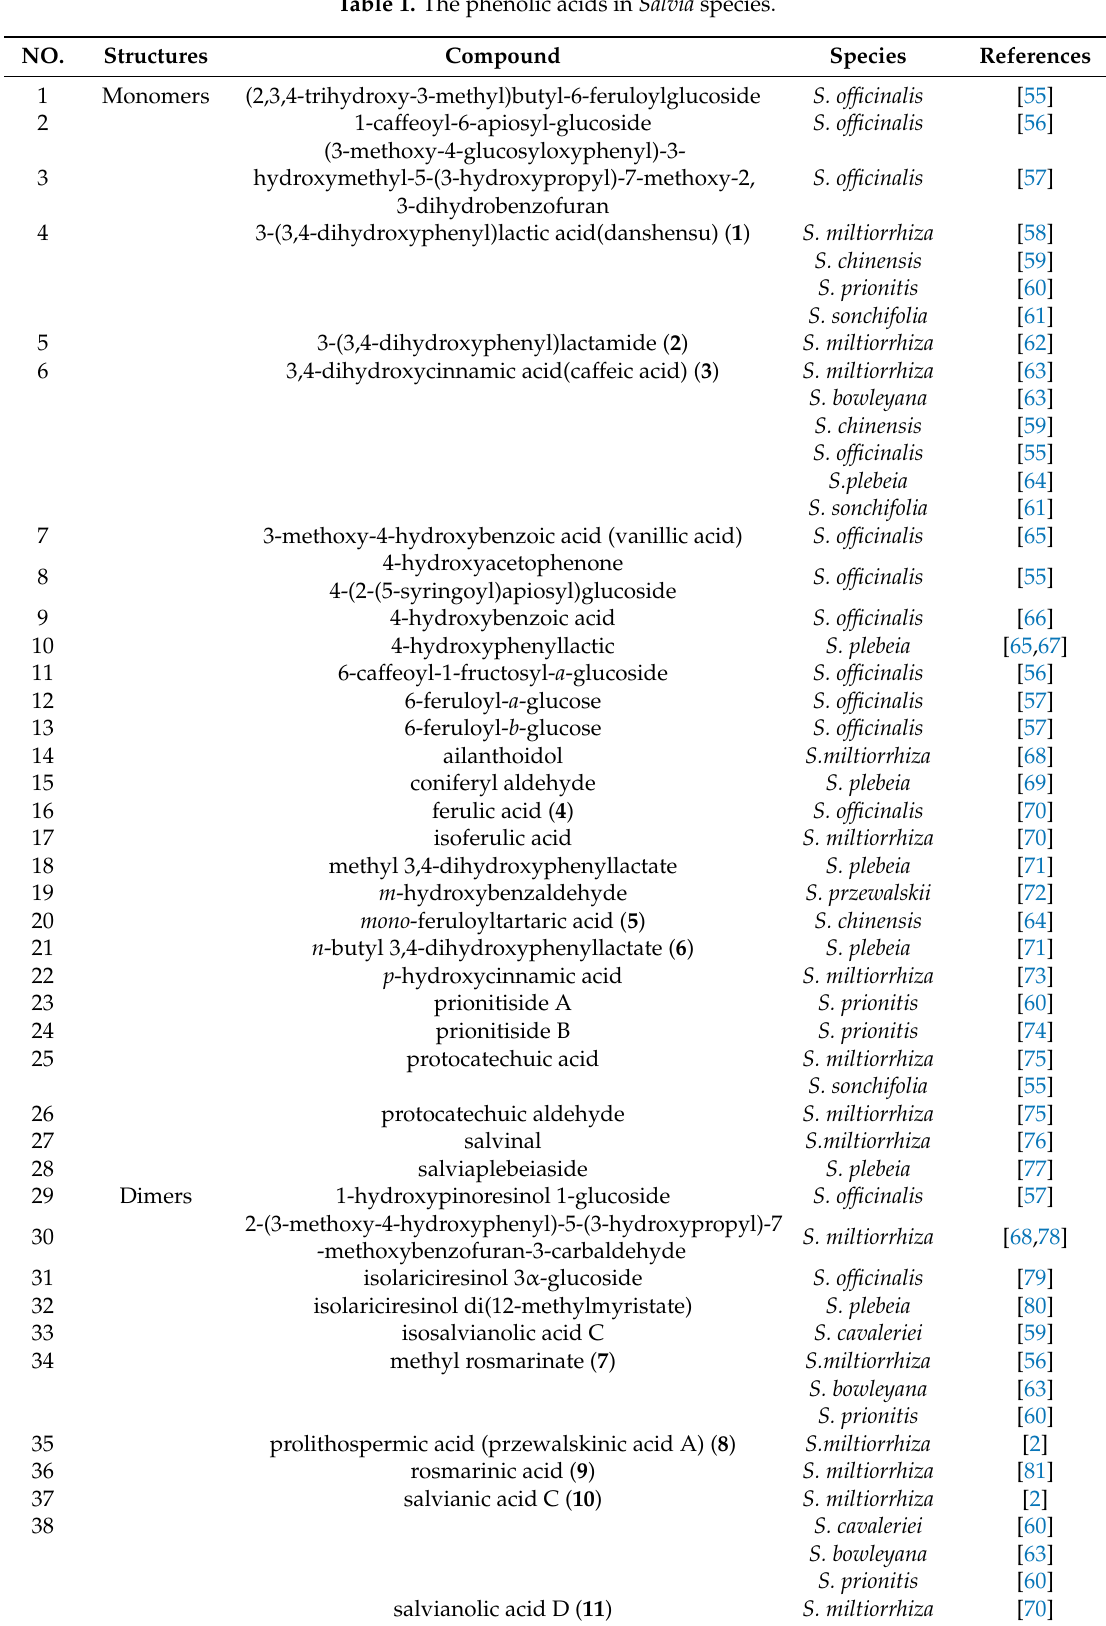
Table 1. The phenolic acids in Salvia